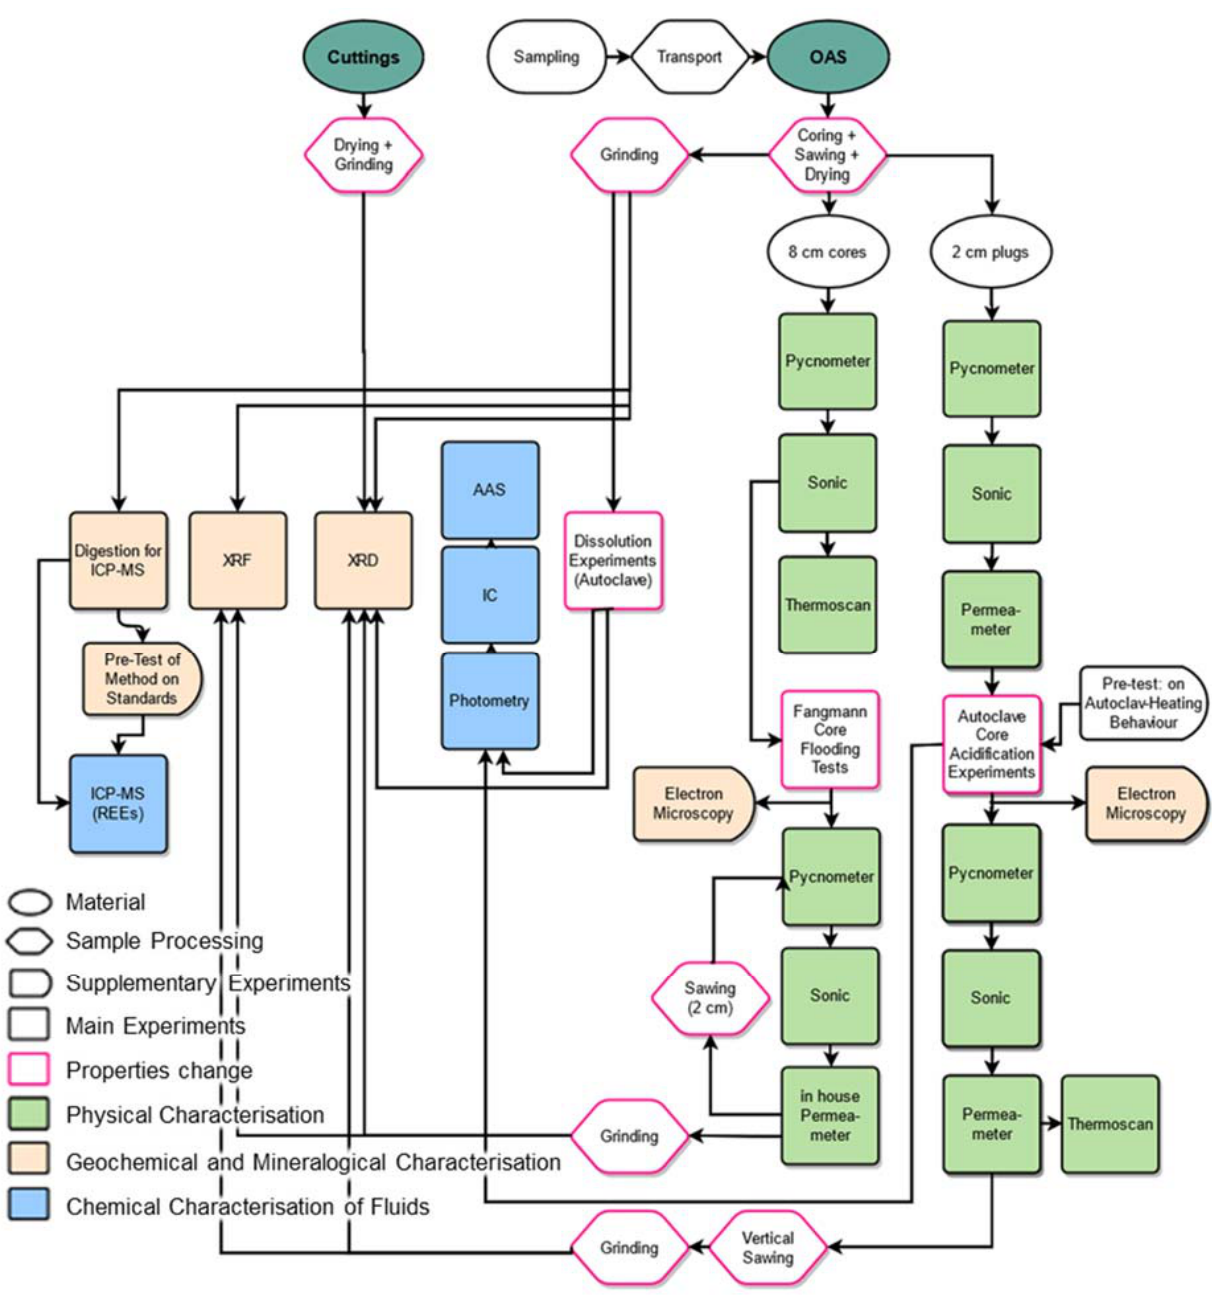
Figure 3. Flow chart of the lab work.